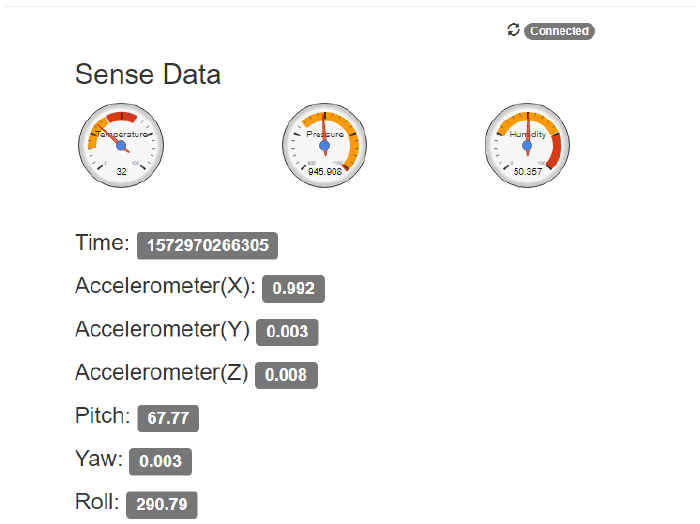
Figure 11. Single dashboard for sensor